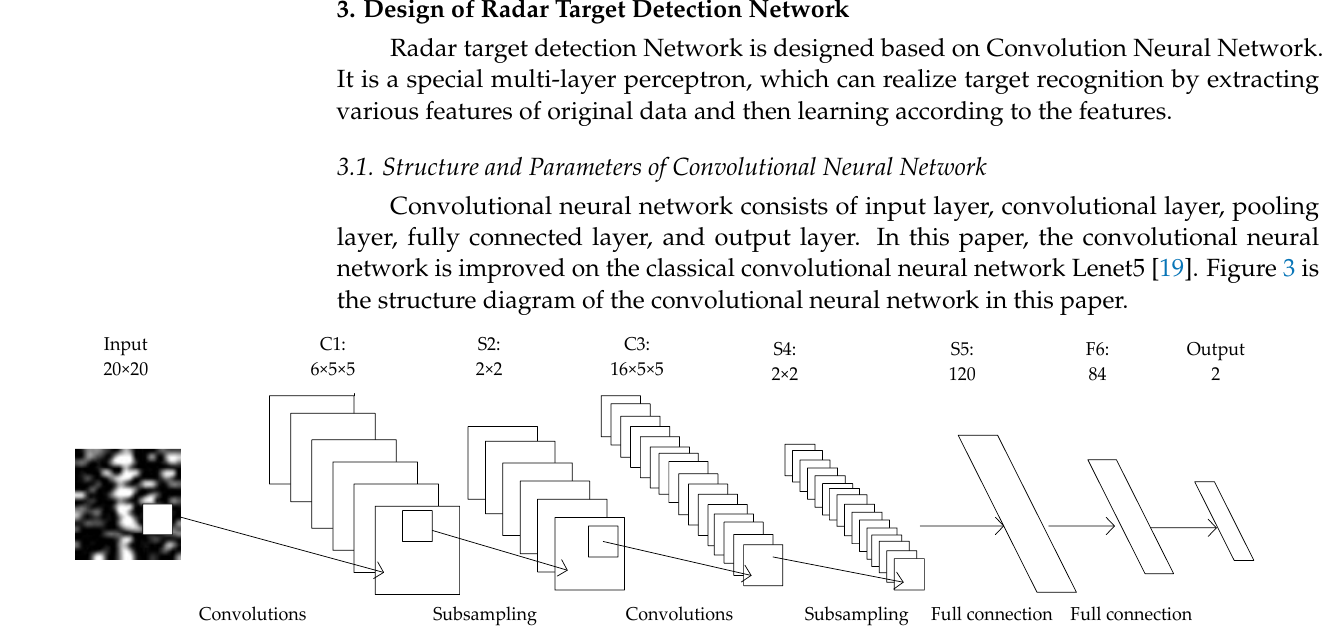
Figure 3. The structure diagram of the convolutional neural network in this paper. 1. Input layer: the input layer is used to receive the original input data or images and preprocess them. 2. Convolutional layer: The convolutional layer is the core of the convolutional neural network, which acts on the information features of data or images through a certain size of convolution kernel. The main function of the convolutional layer is to extract features, and different features are calculated by different convolution kernels [24]. Assume that the input image is a 5 × 5 matrix, and the radar simulation echo signal image of 12 dB SNR is taken as the input image, as shown in Figure 4a, the amplitude value is shown in Figure 4b, and the convolution kernel is a 3 × 3 matrix as shown in Figure 4c: